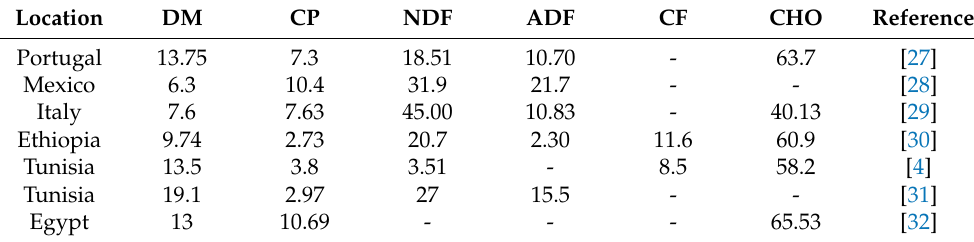
Table 1. Chemical composition (% DM) of O. ficus-indica according to different locations.